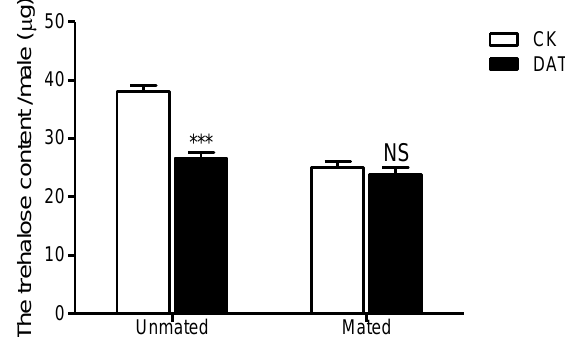
Figure 6. The trehalose content of males was determined in the CK group (at 19 h after emergence) and DAT group (males treated with 0.01% diallyl trisulfide for 7 h at 12 h after emergence) both before and after mating. The data in the figure are presented as the mean ± SEM. Asterisks depict significant differences relative to the control treatment (NS, no significant difference, ***, p < 0.001).